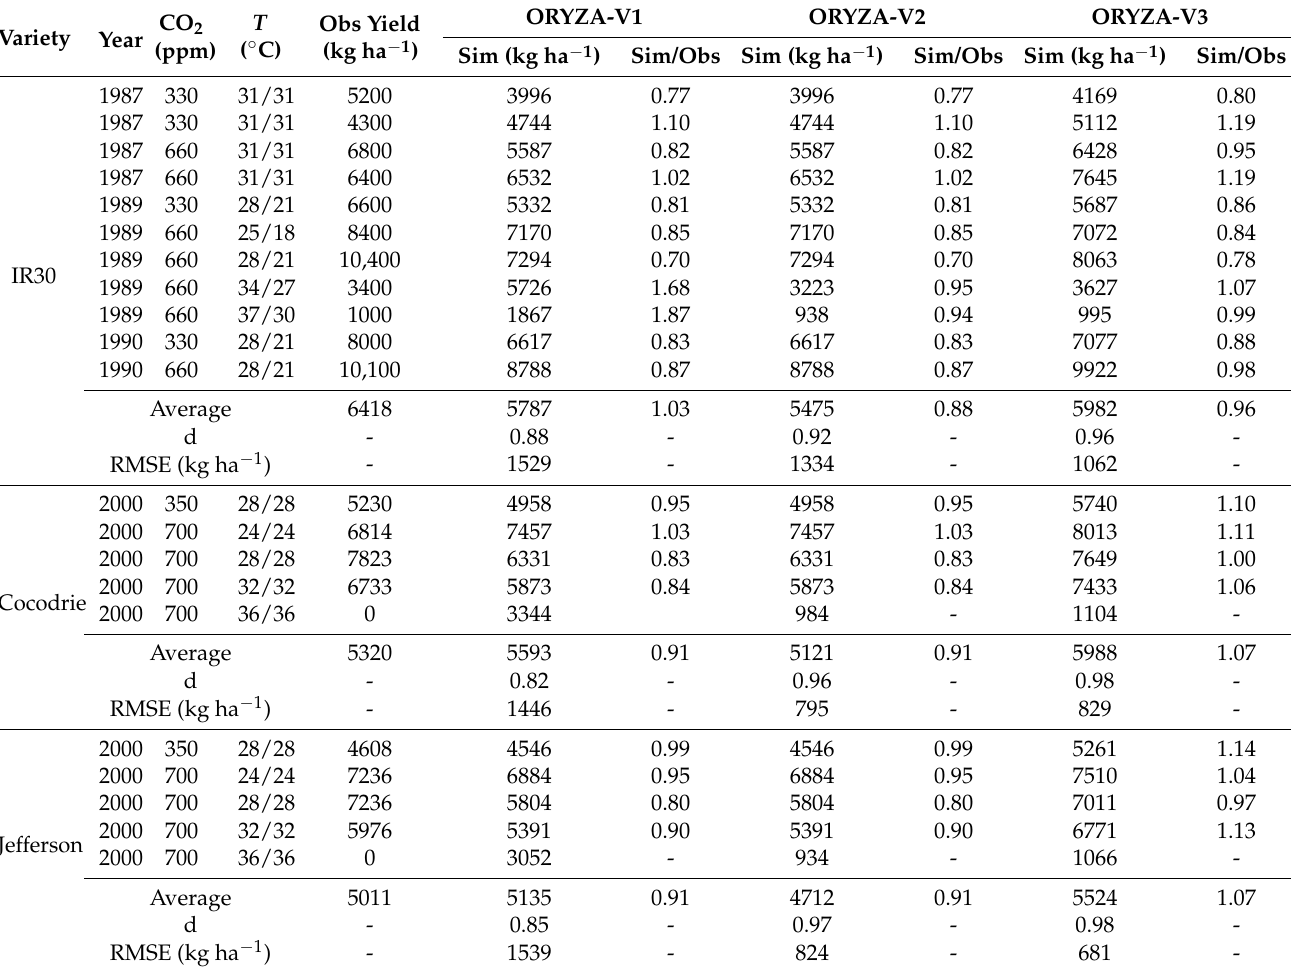
Table 2. Comparison of observed (Obs) and simulated (Sim) rice grain yield for ORYZA-V1, -V2, and -V3 model versions in response to CO 2 and day/night temperature ( T ) treatments for three rice varieties. The ratio of simulated to observed final biomass (Sim/Obs) was indicated for each individual treatment, and Wilmott’s index of agreement (d) and RMSE computed across all treatments for each variety.